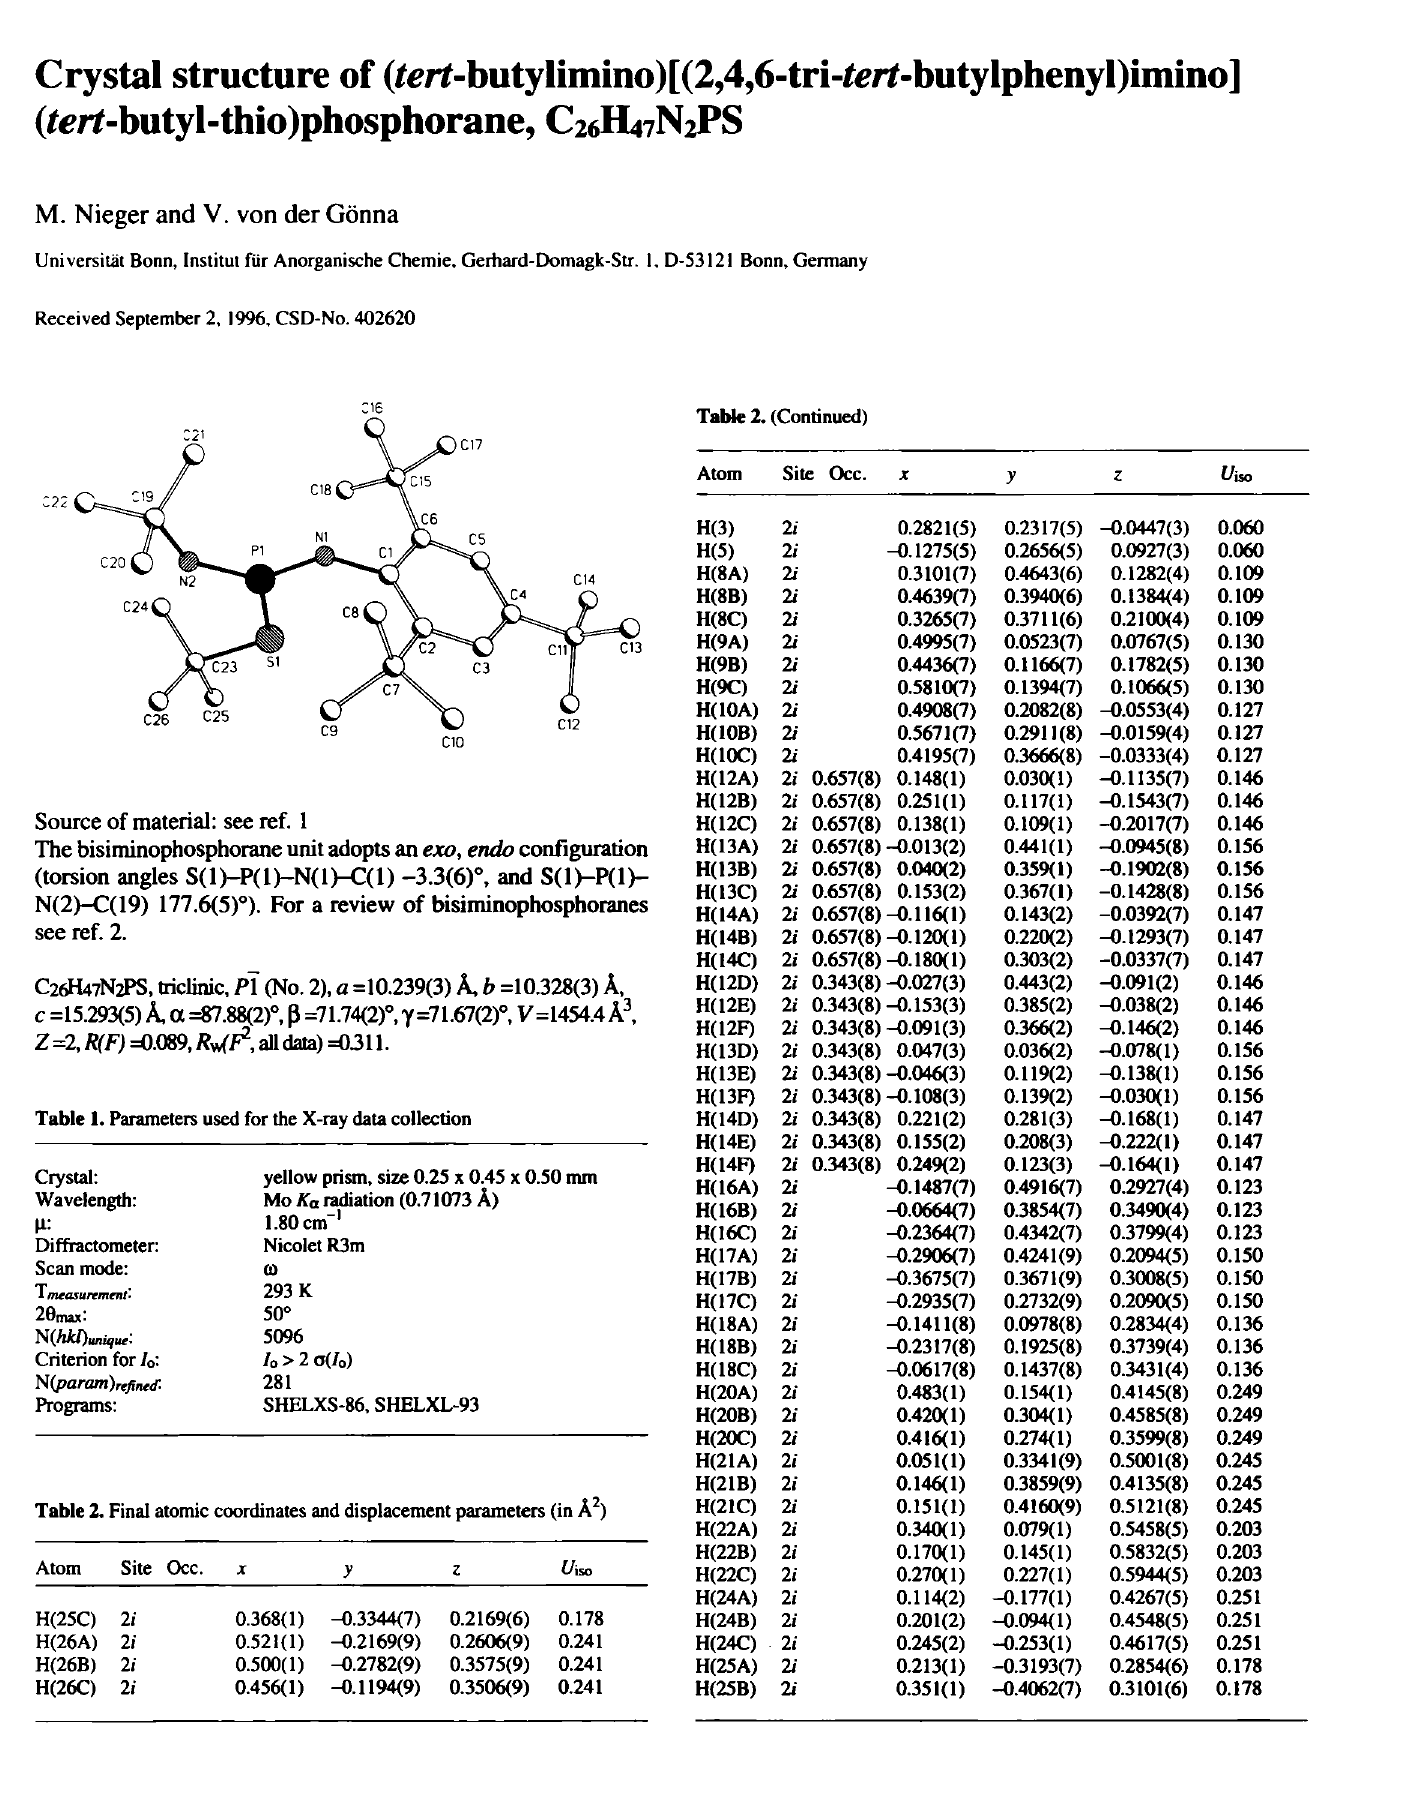
Table 1. Parameters used for the X-ray data collection Crystal: